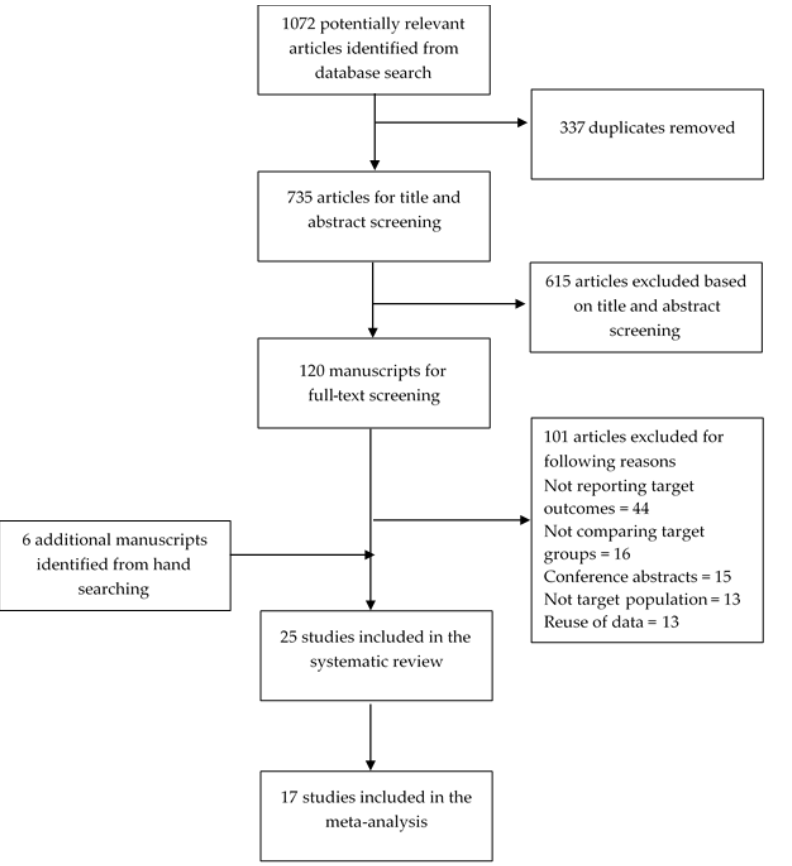
Figure 1. Flow of information through the different phases of the review.